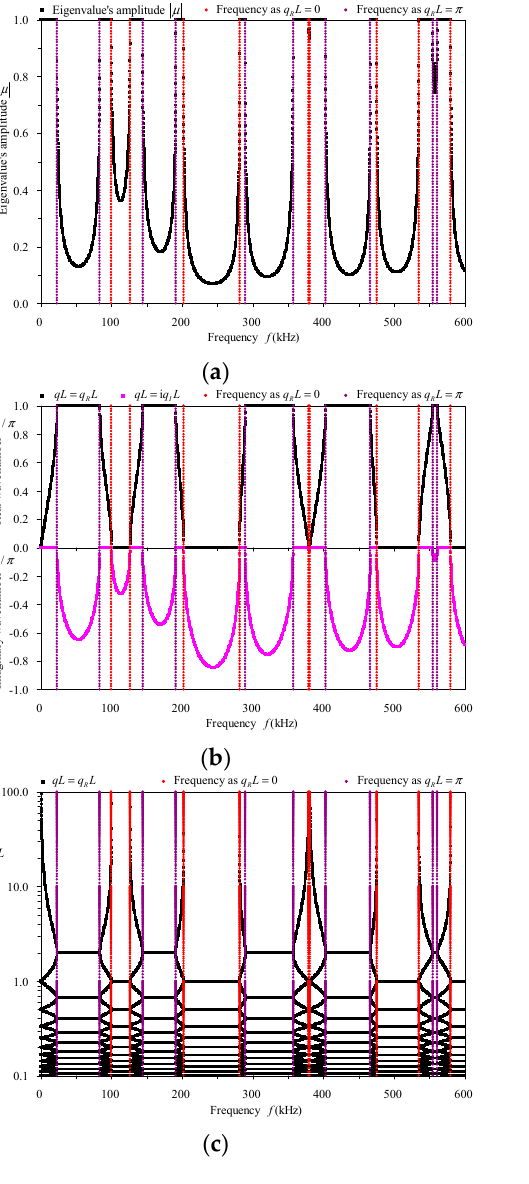
Figure 10. Various frequency-related dispersion curves of the periodic Epoxy-Brass-PZT-5H-Brass composite rod in low frequency range: ( a ) eigenvalue’s amplitude spectra; ( b ) wavenumber spectra; ( c ) wavelength spectra in logarithmic coordinate; ( d ) phase velocity spectra in logarithmic coordinate; and ( e ) phase velocity spectra in a small scale.